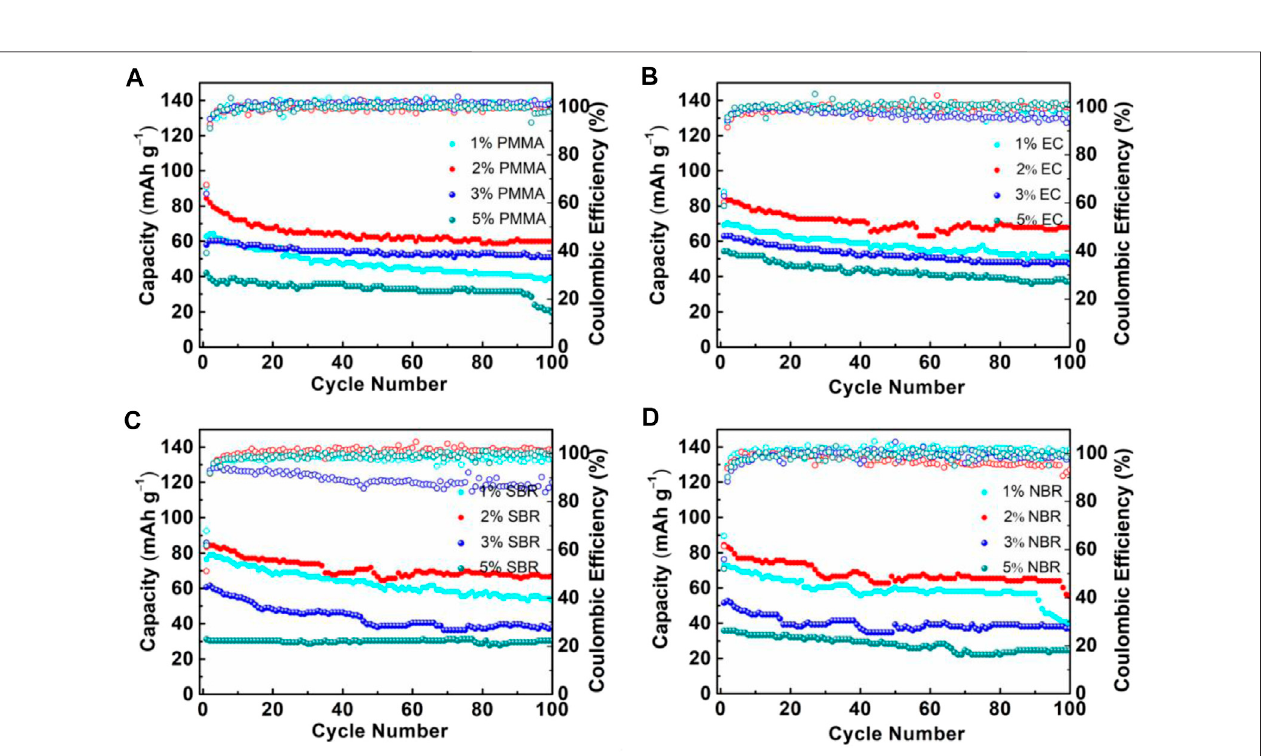
Frontiers in Materials |